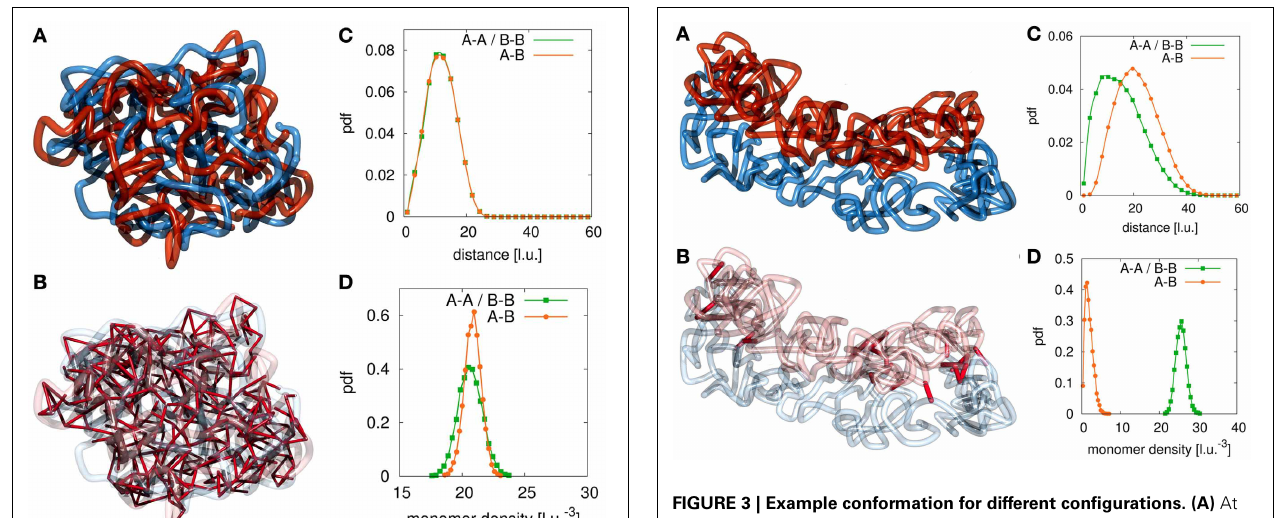
FIGURE 3 | Example conformation for different configurations. (A) At certain values of the interlink concentration, sister chromatids segregate due to entropic repulsion but are still concatenated by a few interlinks. These configurations resemble the situation found in sister chromatid systems in metaphase. When the interlink concentration is further decreased, the two chromatin fibers separate completely from each other. (B) This figure highlights the present interlinks between the sister fibers. Interlinks are found along the contour of both model chromatids. (C) The radial distribution function between monomers of different fibers is shifted to larger values compared to the function between monomers of the same fiber. (D) The concentration of monomers of the own fiber is much higher than the concentration of monomers of the sister fiber around one